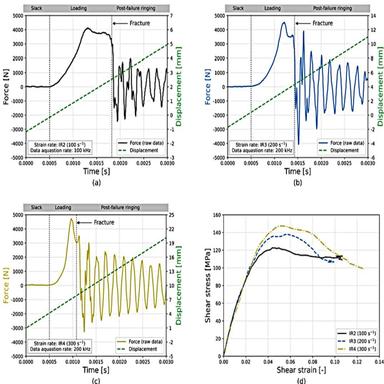
Comparison of raw force-time signals, including displacement profiles, from dynamic in-plane shear testing at different nominal strain rates: (a) 100 s − 1 ; (b) 200 s − 1 ; (c) 300 s − 1 ; and (d) their derived dynamic shear stress-strain data.